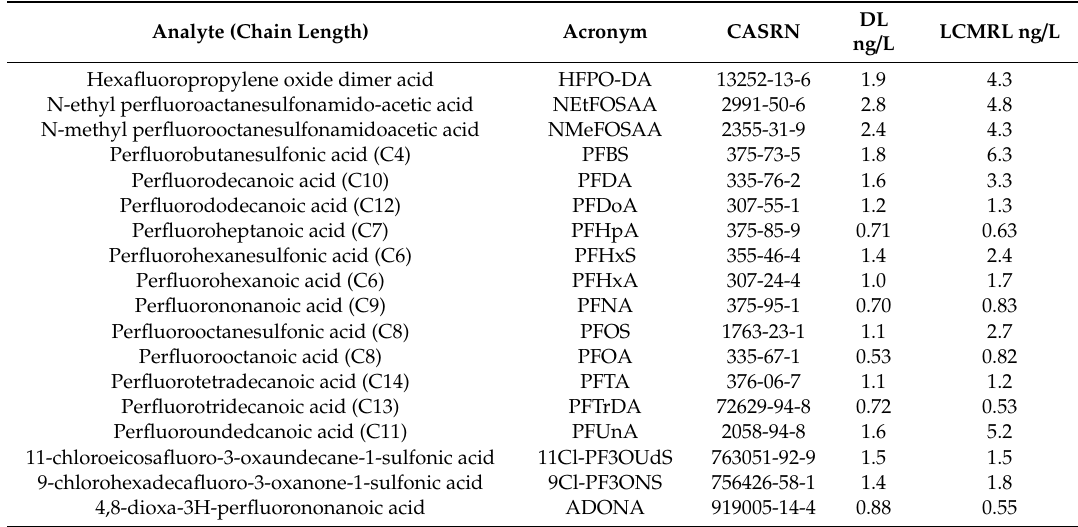
Table 1. Compounds detectable by USEPA Method 537.1 [31]. USEPA: US Environmental Protection Agency; CASRN: Chemical Abstract Service Registration Number; LCMRL: Lowest Concentration Minimum Reporting Level; DL: Detection